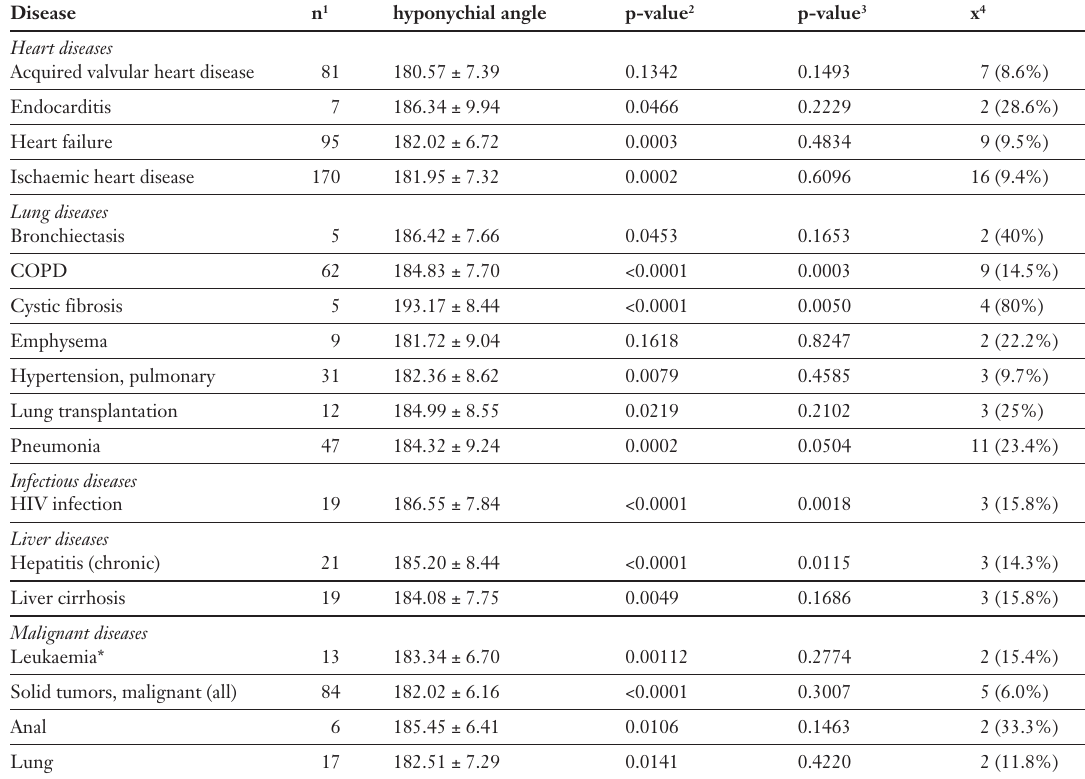
Hyponychial angles of various patient